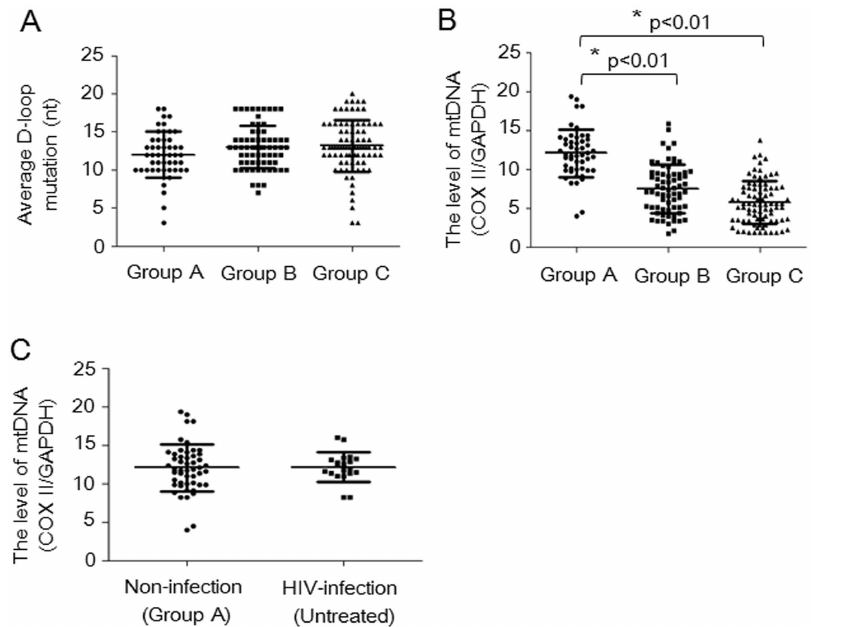
figure 3A. TK2 transcription levels in PBMCs did not differ